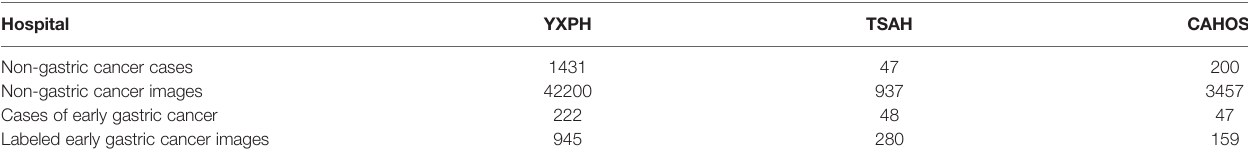
TABLE 1 | Number of cases and images contributed by the three hospitals. Hospital